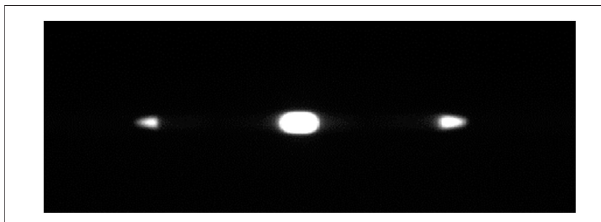
FIGURE 7 | Measurement of the collimation results.